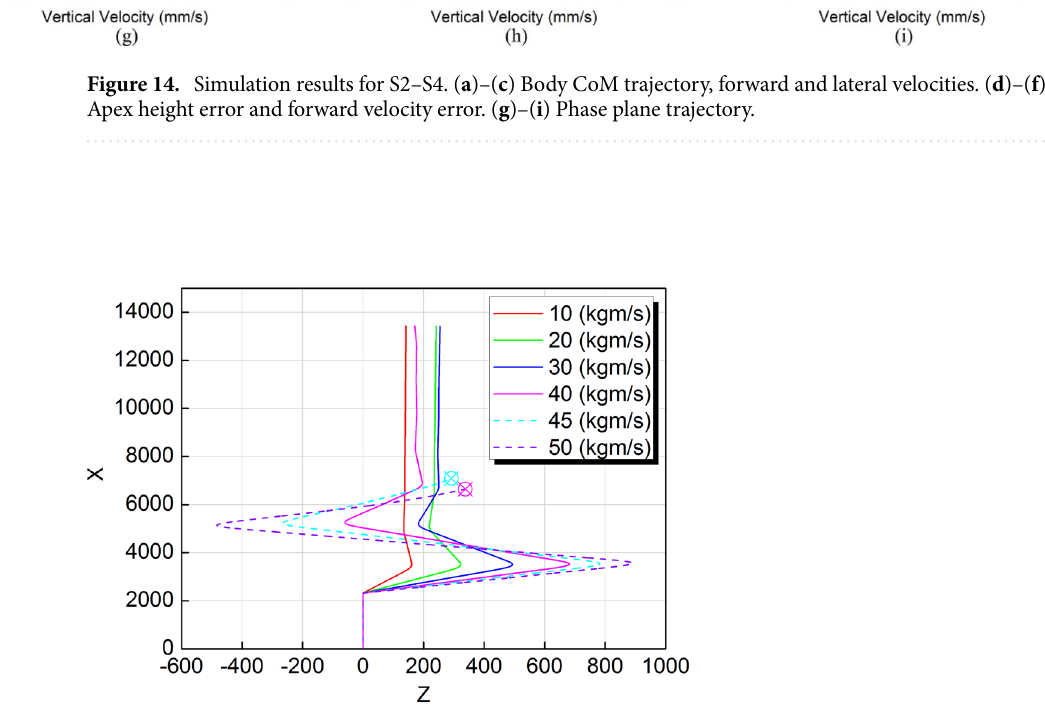
Figure 15. Motion paths in Z-X plane under different impact